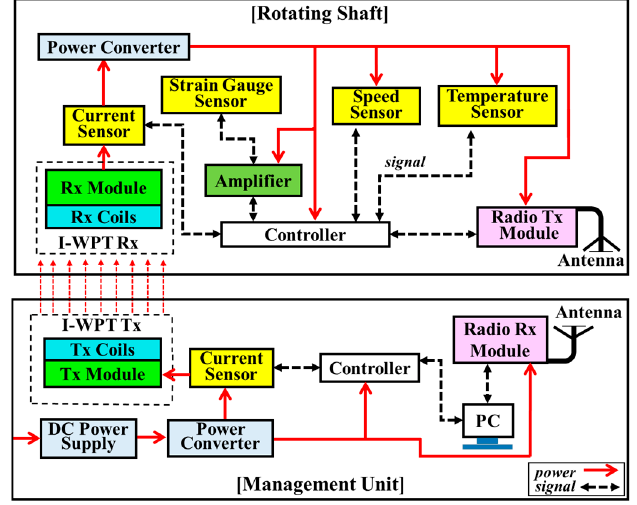
Figure 3. Block diagram of the entire WSS, integrating four sensors on the rotating